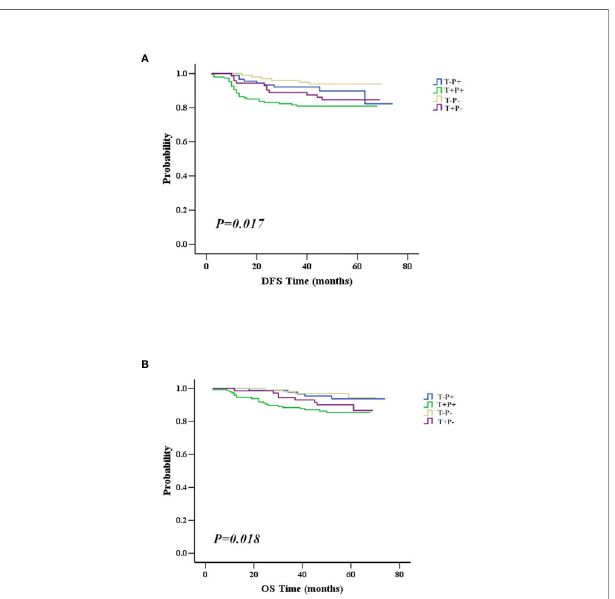
FIGURE 4 | Association between mutant p53 and Twist1 co-expression with survival. (A) Patients with mutant p53 and Twist1 co-expression (T+P+) have worst DFS than patients in other groups, including Twist1- and mutant p53- (T-P-), Twist1+ and mutant p53- (T+P-), and Twist1- and mutant p53+ (T-P+) ( P = 0.017). (B) Patients with co-expression of mutant p53 and Twist1 (T+P+) have worst OS compared to patients in other groups, including Twist1- and